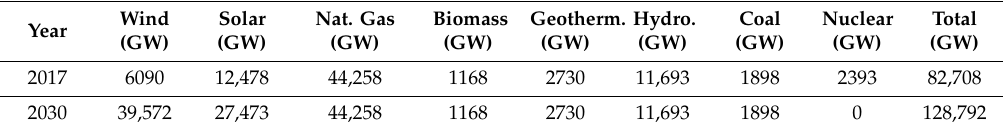
Table 13. SWITCH Modeling Results for California—Generation Capacity in GW.